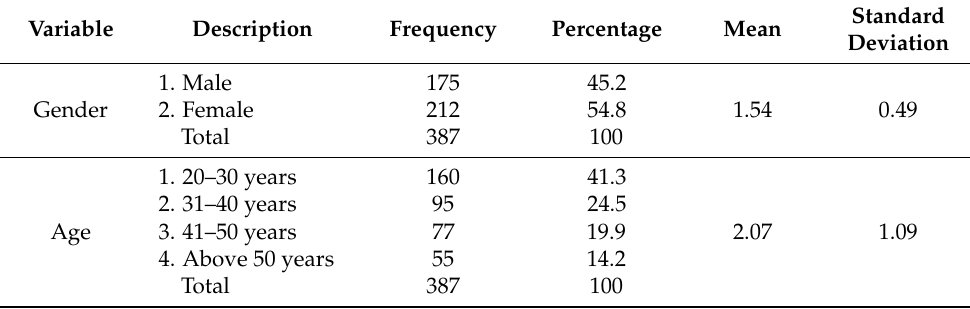
Table 3. Basic respondents’ information results.